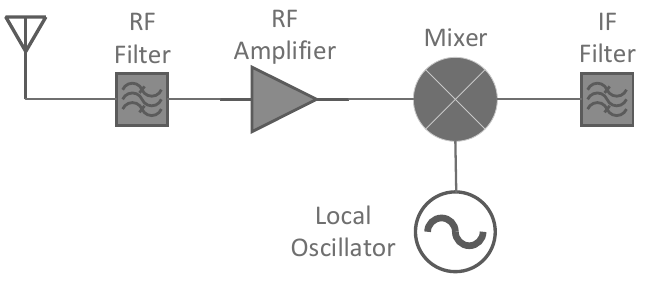
Figure 1. Basic components of a receiver.